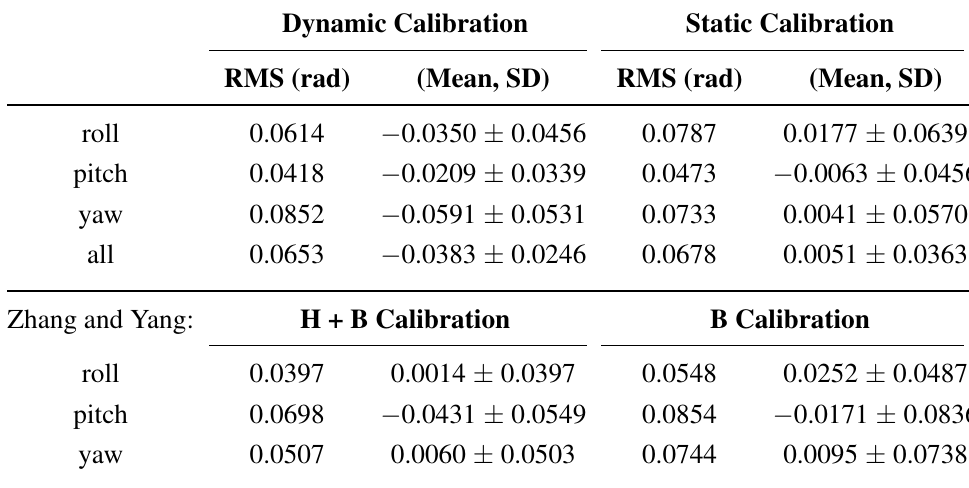
Table 2. Statistical evaluation of 10 consecutive calibration trials with arbitrary movements compared to the reference